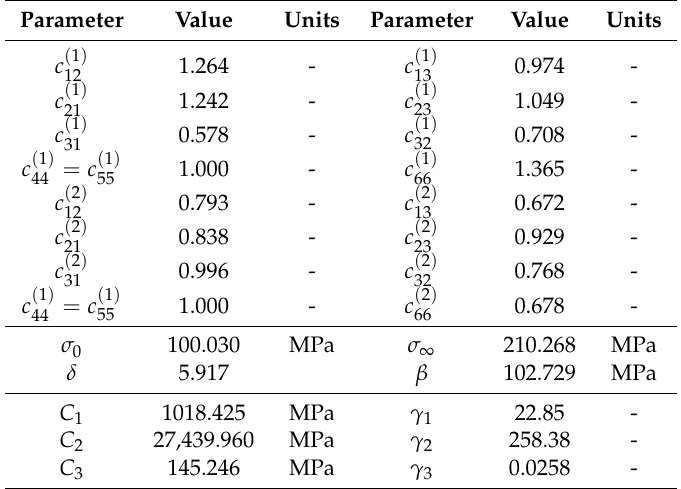
Table 2. Constitutive model parameters used in this work. Data from [17].